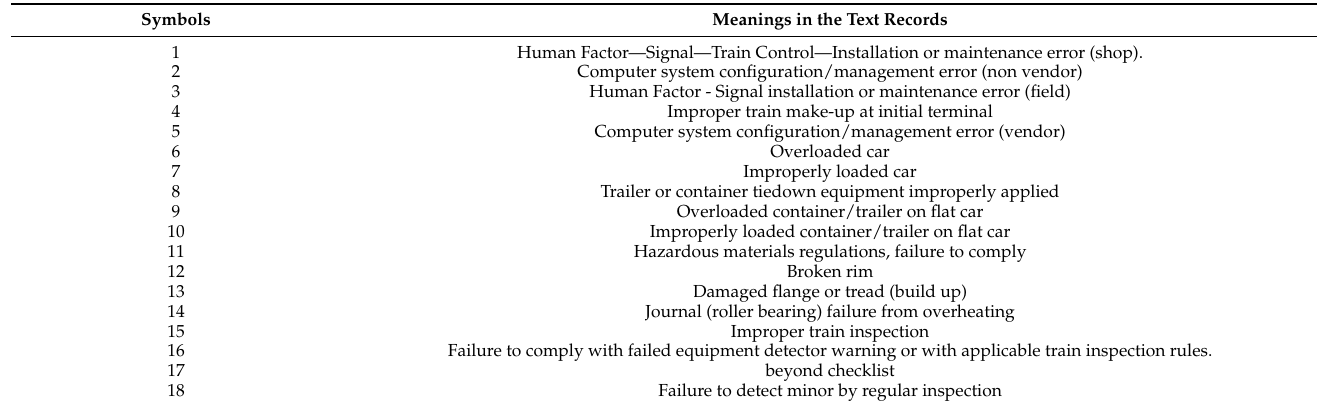
Table A1. The following symbols are used in Figure 7a.